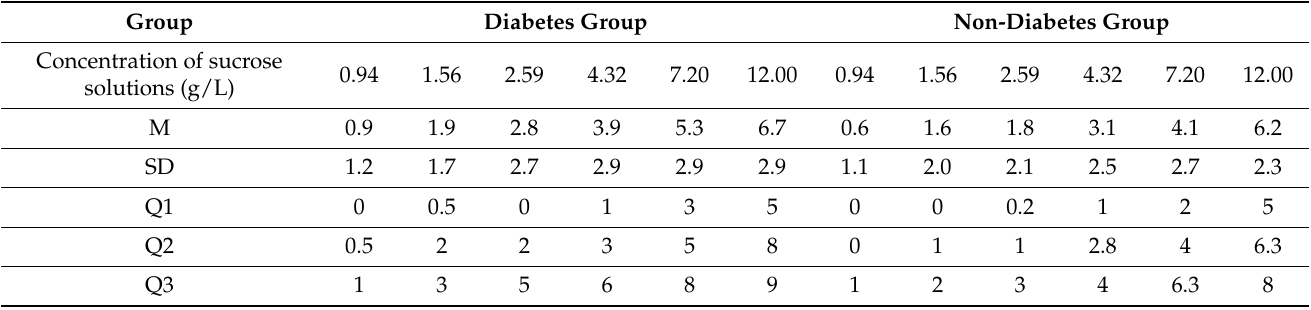
Table 6. Evaluation of the intensity of the perceived taste of sucrose solutions by